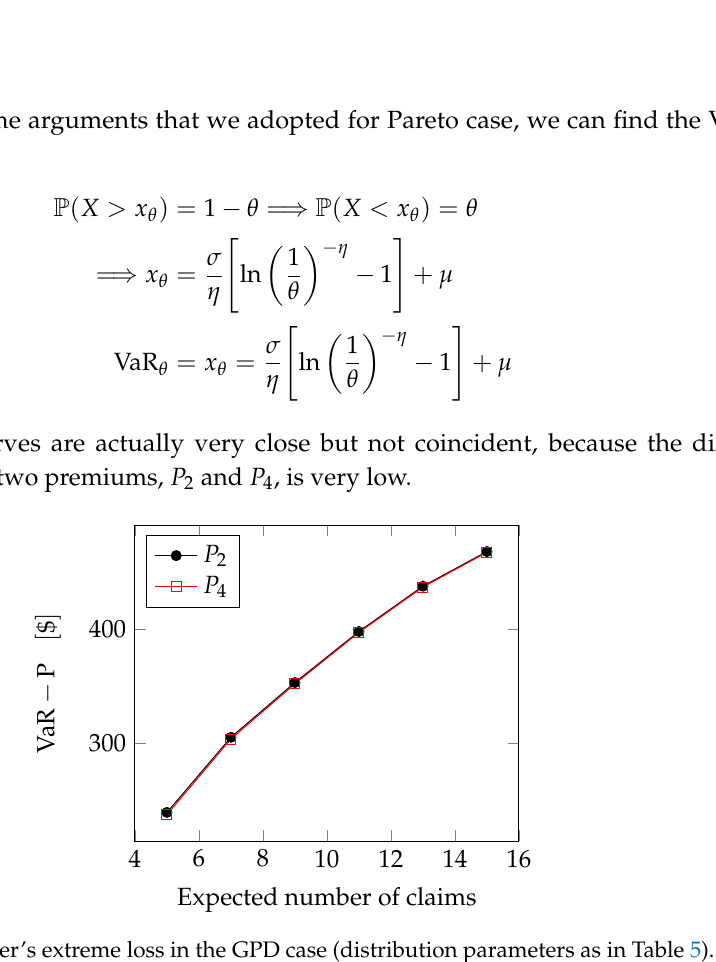
Figure 8. Insurer’s extreme loss in the GPD case (distribution parameters as in Table